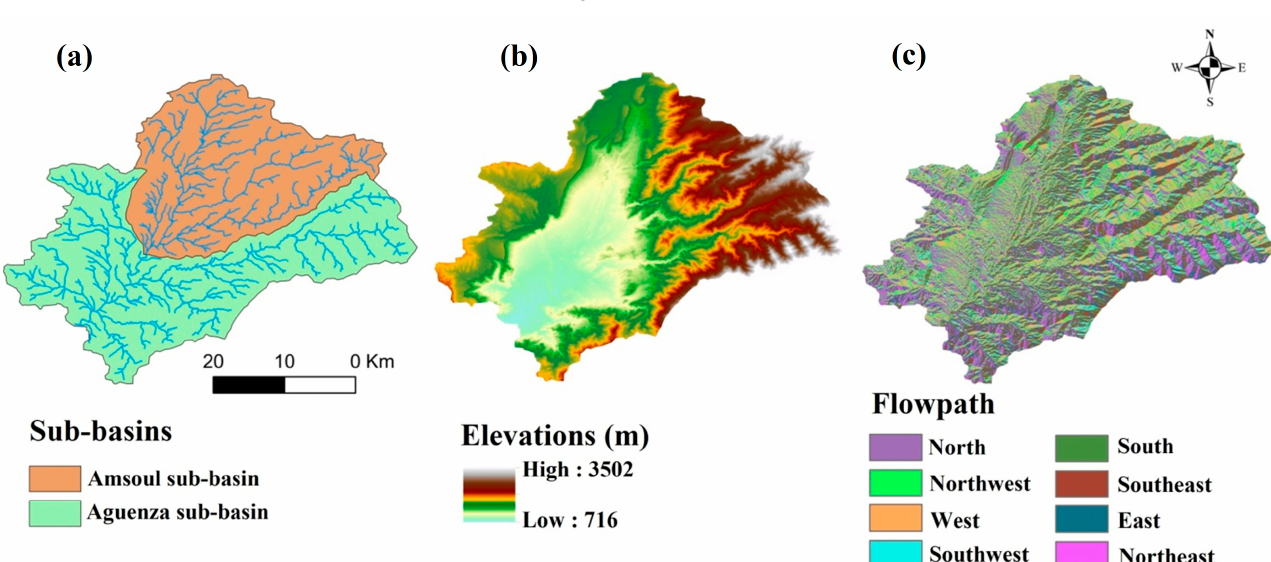
Figure 2. ( a )The hydrographical network map with the sub-basins, ( b ) altitude map of Aguenza watershed; ( c ) drainage directions map.